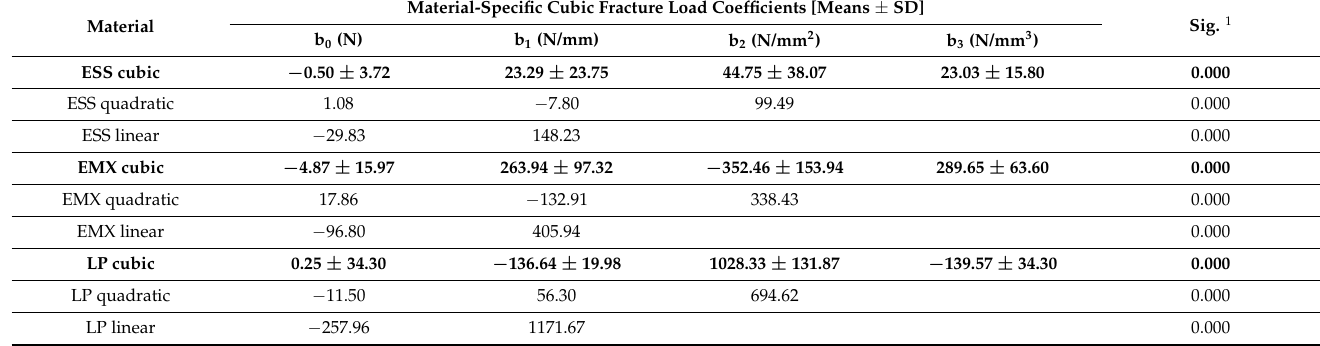
Figure 7. Cubic regression curves for all three materials examined. Table 4. The material-specific fracture load coefficients b 0 , b 1 , b 2 , and b 3 for the cubic, quadratic, and linear equations. ( p ≤ Table 3. R 2 values of the linear, quadratic, and cubic regression curves.